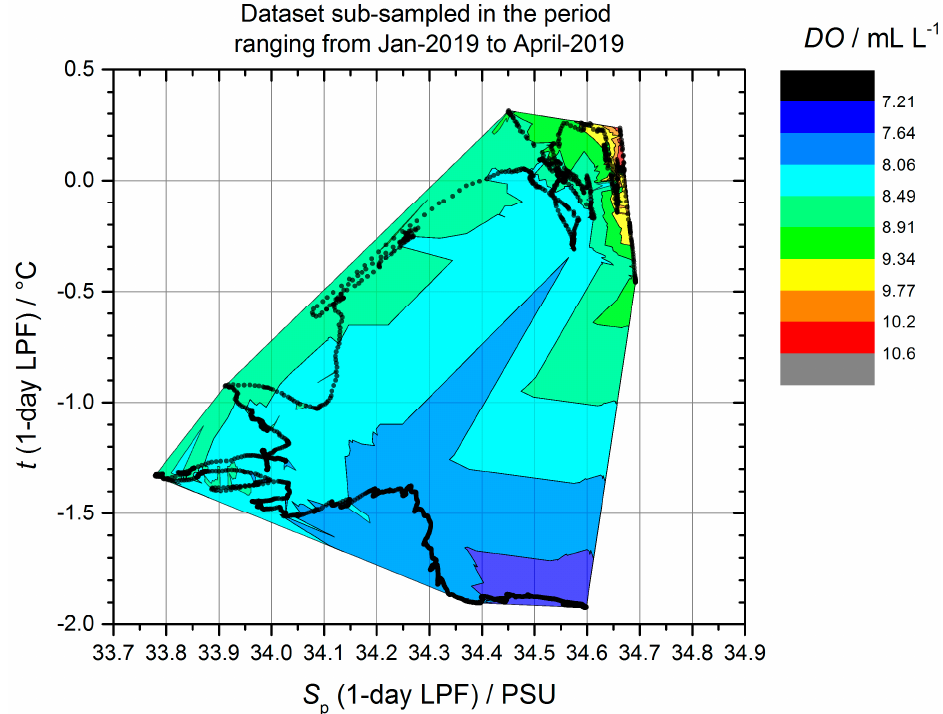
Figure 8. Relationship between t , S P , and DO during the summer season (January–April 2019) in Terra Nova Bay.